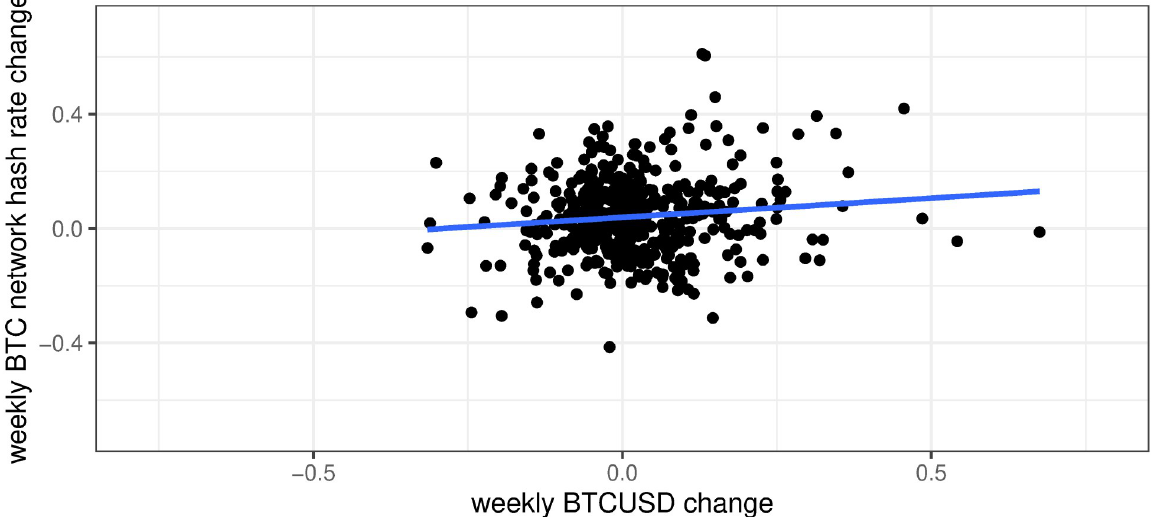
Fig 19. Weekly BTCUSD change vs weekly BTC network hash rate change. Descriptive statistics for BTCUSD weekly change: n = 448, min = -0.315, max = 0.675, mean = 0.02, median = 0.003, std dev = 0.116, skewness = 1.063, kurtosis = 3.875. Descriptive statistics for hashrate weekly change: n = 448, min = -0.414, max = 0.611, mean = 0.042, median = 0.035, std dev = 0.137, skewness = 0.438, kurtosis = 1.113. Note: Data covers the period between 2013/05/01 to 2021/12/03. Own calculation based on the data from: https://charts.coinmetrics.io/network-data/, https://api.